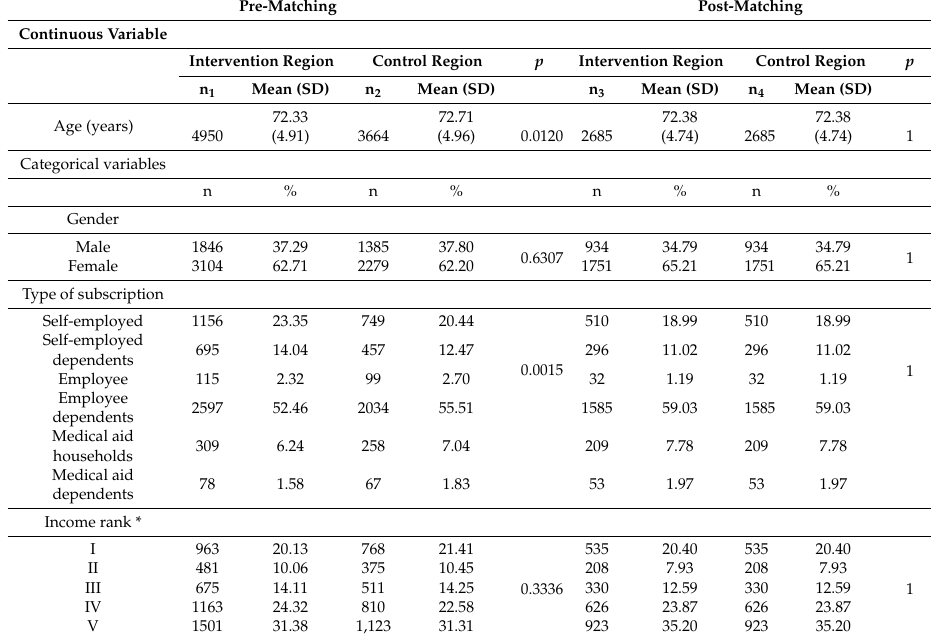
Table 1. Results of homogeneity test on final study subjects according to matching between study regions: Predisposing and need factors on the Andersen model.